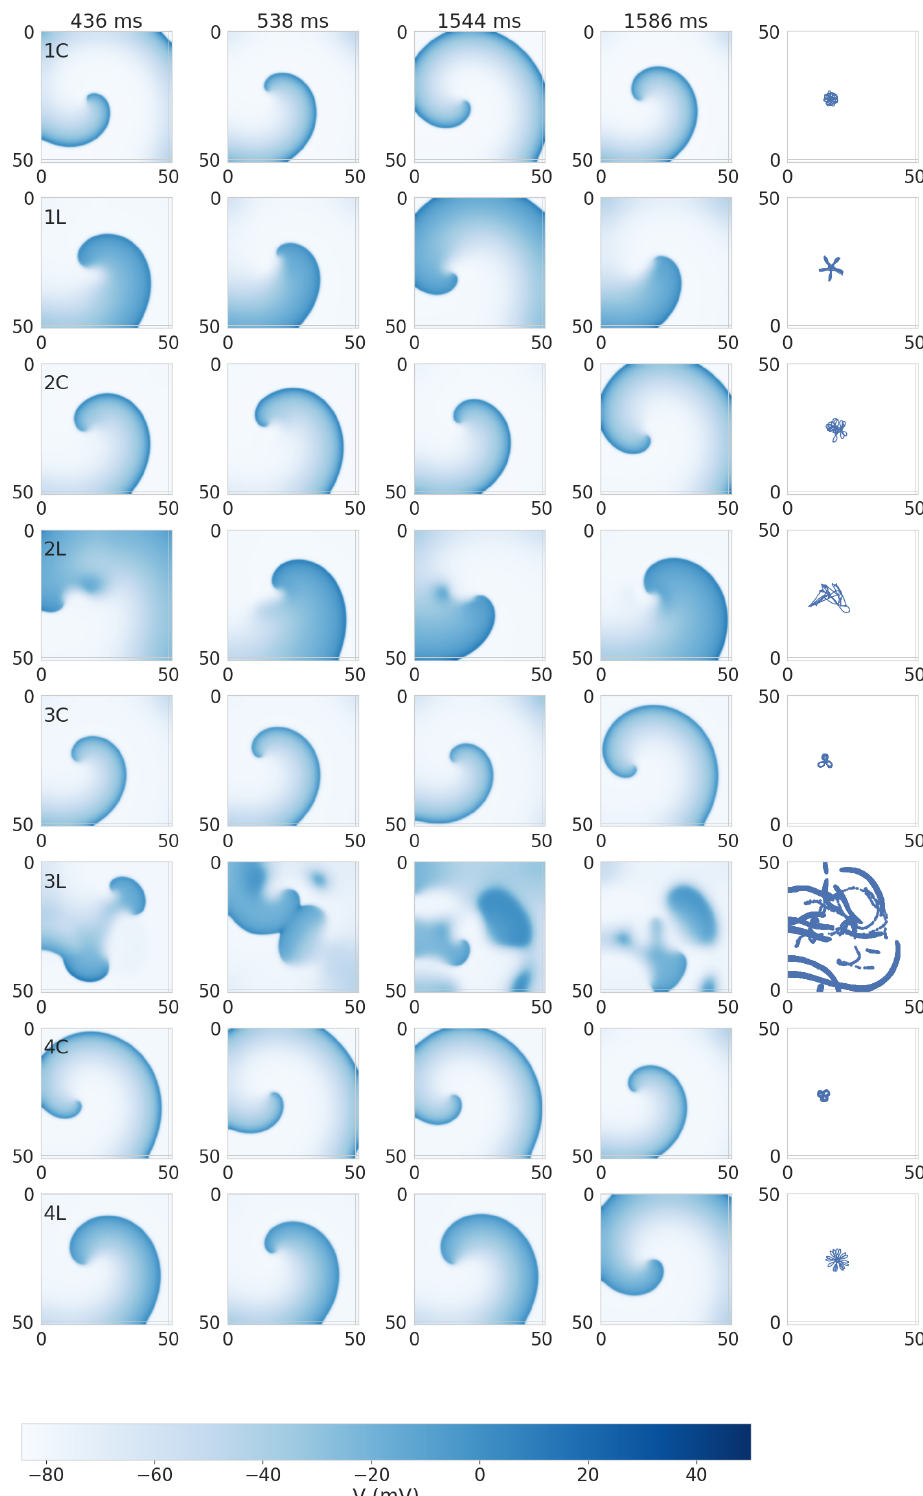
Figure 5. Spiral wave dynamics in 2D tissue with cellular Models 1–4 in the control (C) and under leptin application (L). The models are labeled in the left panels. Snapshots of transmembrane voltage at several moments of time are shown. The right column shows the tip trajectory detected using the Fenton and Karma algorithm [34] in the time window from 0.5 to 1.5 s after spiral initiation. The transmembrane potential color scale is given at the